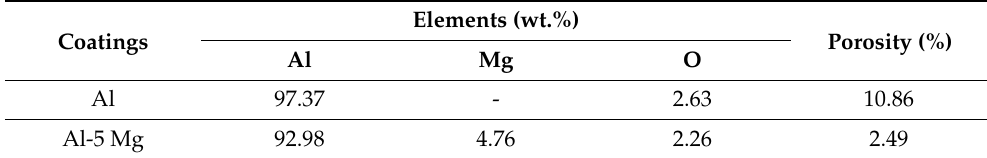
Figure 3. Cross section SEM images of ( a ) Al and ( b ) Al-5 Mg coatings deposited by plasma arc thermal spray process at 500× . Table 1. EDS analysis of the deposited coatings.